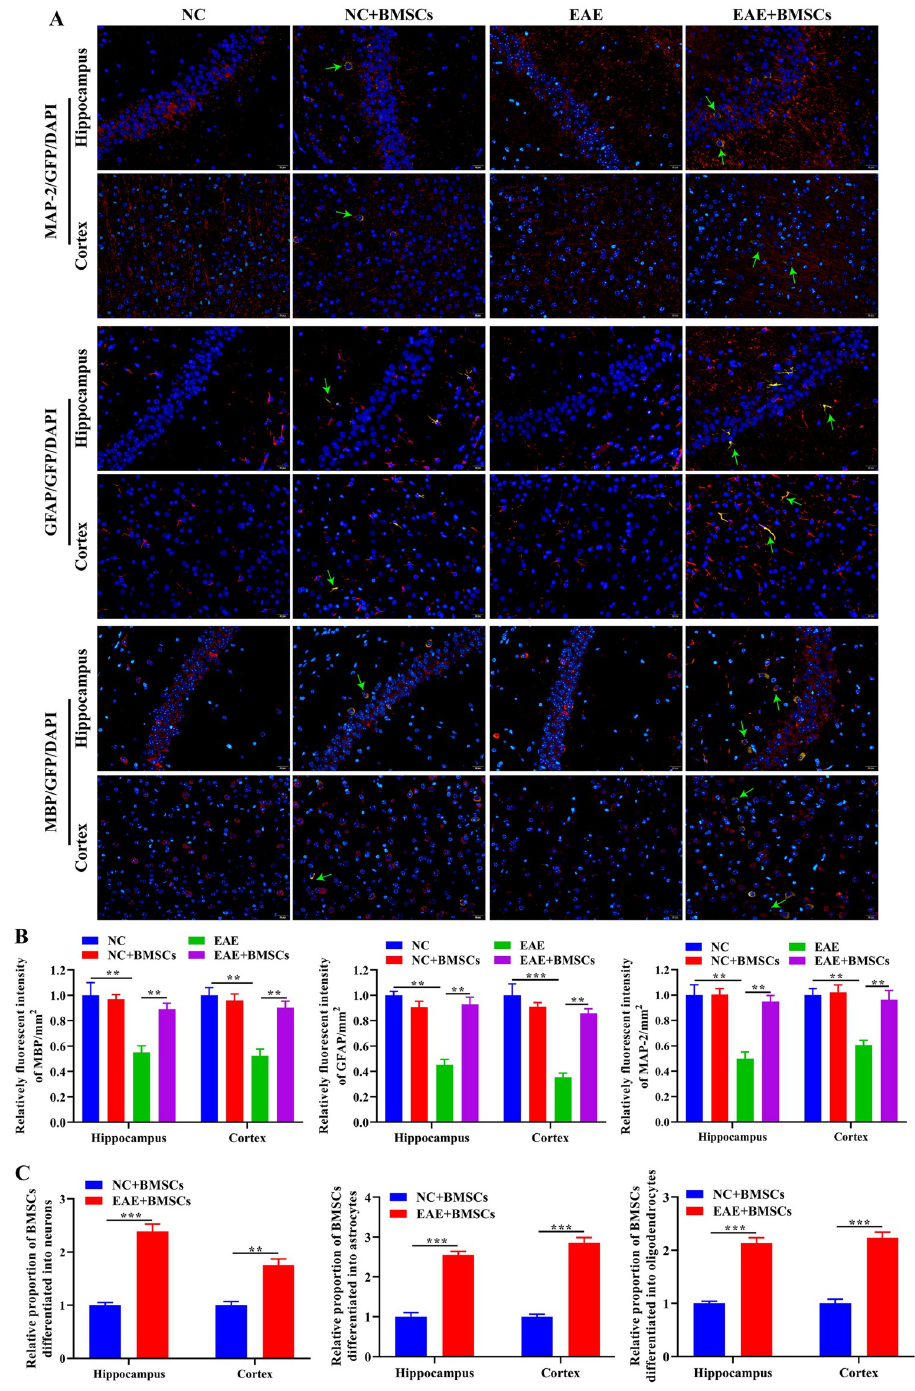
Fig 3. The transplanted BMSCs differentiated into neurons, astrocytes and oligodendrocytes in the EAE mice. On the 16th day post-immunization, the mice of each group were euthanized. (A) IF staining exhibited the position and level of GFP with MAP-2, GFAP and MBP in hippocampus and cortex. Scale bar = 20 μ m. The green arrows indicated neurons, astrocytes and oligodendrocytes differentiated by BMSCs. (B) The result of MAP-2, GFAP and MBP fluorescence intensity were analyzed by Image J software. (C) In the NC+BMSCs and EAE+BMSCs groups, relative proportion of BMSCs differentiated into neurons, astrocytes and oligodendrocytes, respectively. In all cases, Values are mean ± SD (n = 15 for each group; �� P < 0.01, ��� P < 0.001).